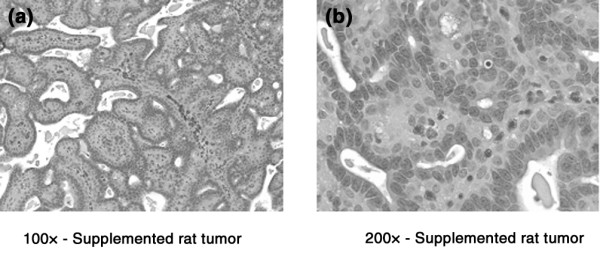
Histological slides showing examples of N-methyl-N-nitrosourea induced mammary tumors in Sprague–Dawley rats fed the supplemented diet (hematoxylin and eosin). Original magnifications: (a) 100× and (b) 200×.